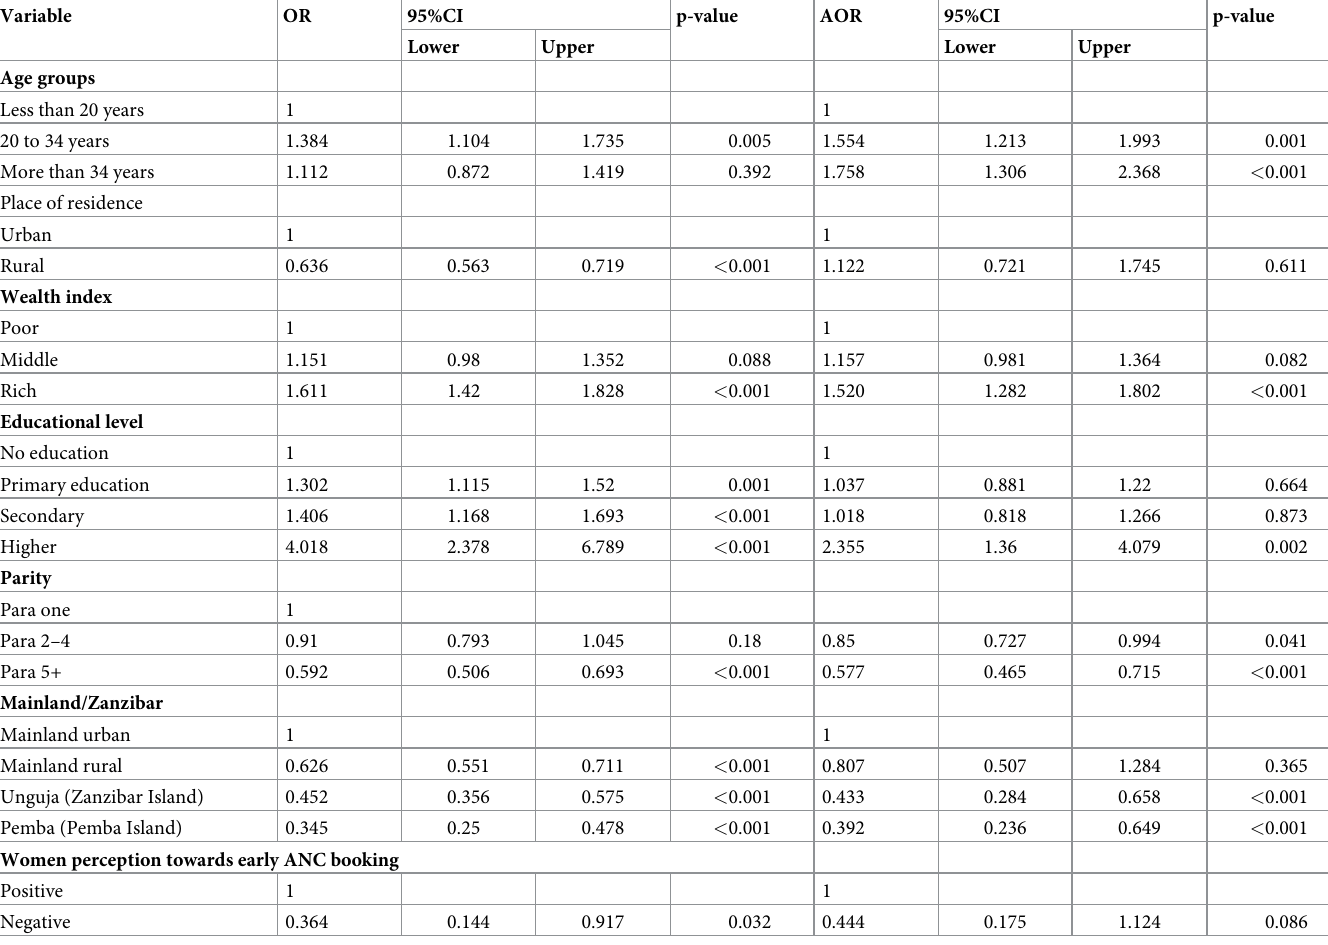
Table 3. Predictors of early antenatal booking among women of reproductive age in Tanzania (n =